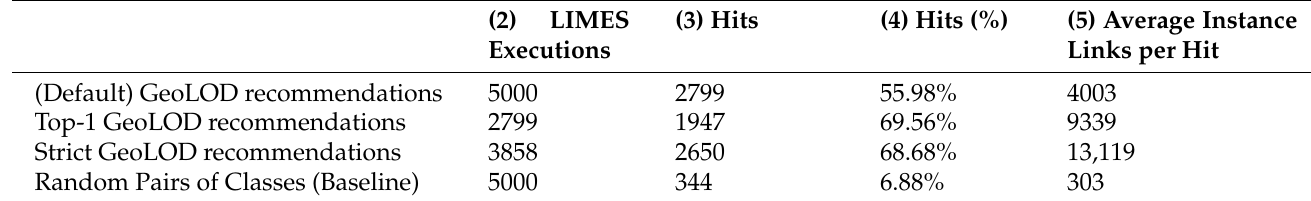
Table 6. GeoLOD recommender evaluation using